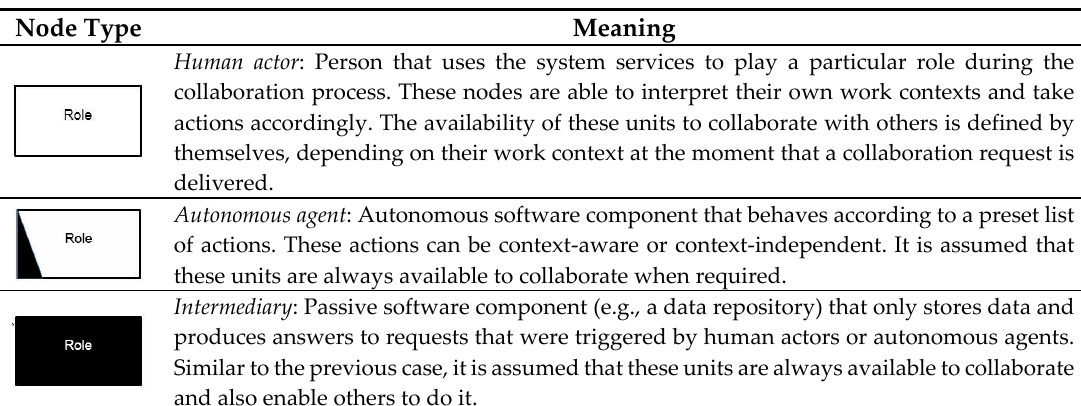
Table 1. Types of nodes supported by the CIMoN